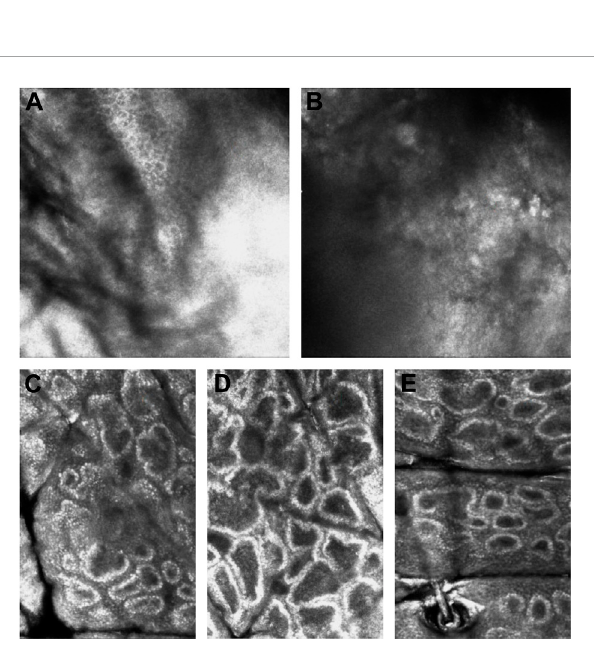
FIGURE 4 Dermoscopy pictures. (A) The dermoscopy picture of the fi rst proband. (B) The dermoscopy picture of the second proband. (C) The dermoscopypictureofthethirdproband. (D) Thedermoscopypicture of the fourth proband. (E) The dermoscopy pictures of the fi fth proband. (F) The dermoscopy pictures of the sixth proband.